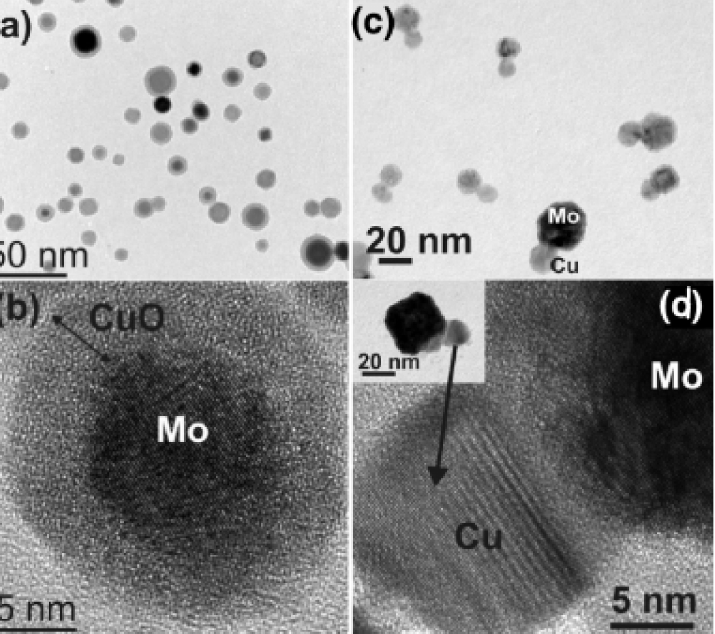
Figure 15. ( a , b ) TEM images of Mo@Cu core–shell nanoparticles produced by a sputter source with a sectioned target (Figure 2a) and an Ar flow rate of 100 sccm. The oxide forms when the particles are removed from the source to obtain the TEM images. ( c , d ) TEM images of Mo-Cu Janus particles produced by employing an Ar flow rate of 150 sccm. Reproduced with permission from